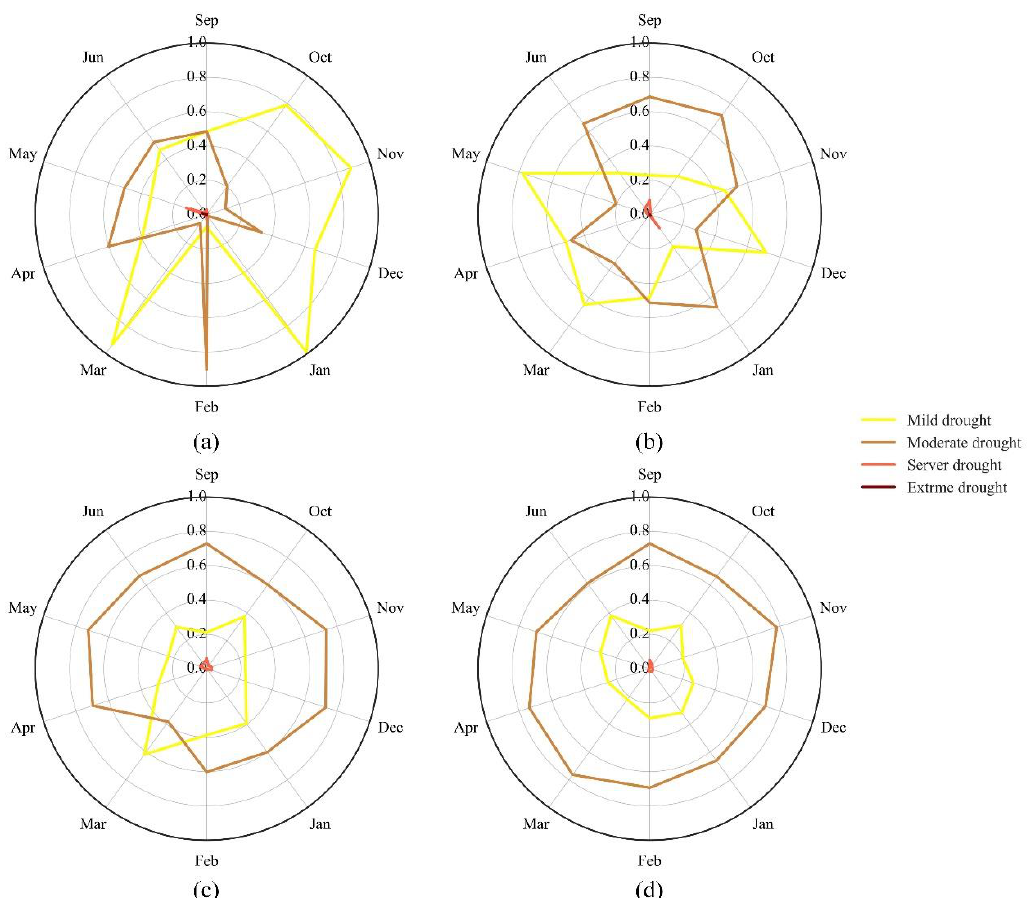
Figure 4. Frequency of different drought levels during winter wheat growth in the NCP from 2001 to 2015 if drought occurred at ( a ) 1, ( b ) 3, ( c ) 6, or ( d ) 9 months. 2015 if drought occurred at ( a ) 1, ( b ) 3, ( c ) 6, or ( d ) 9